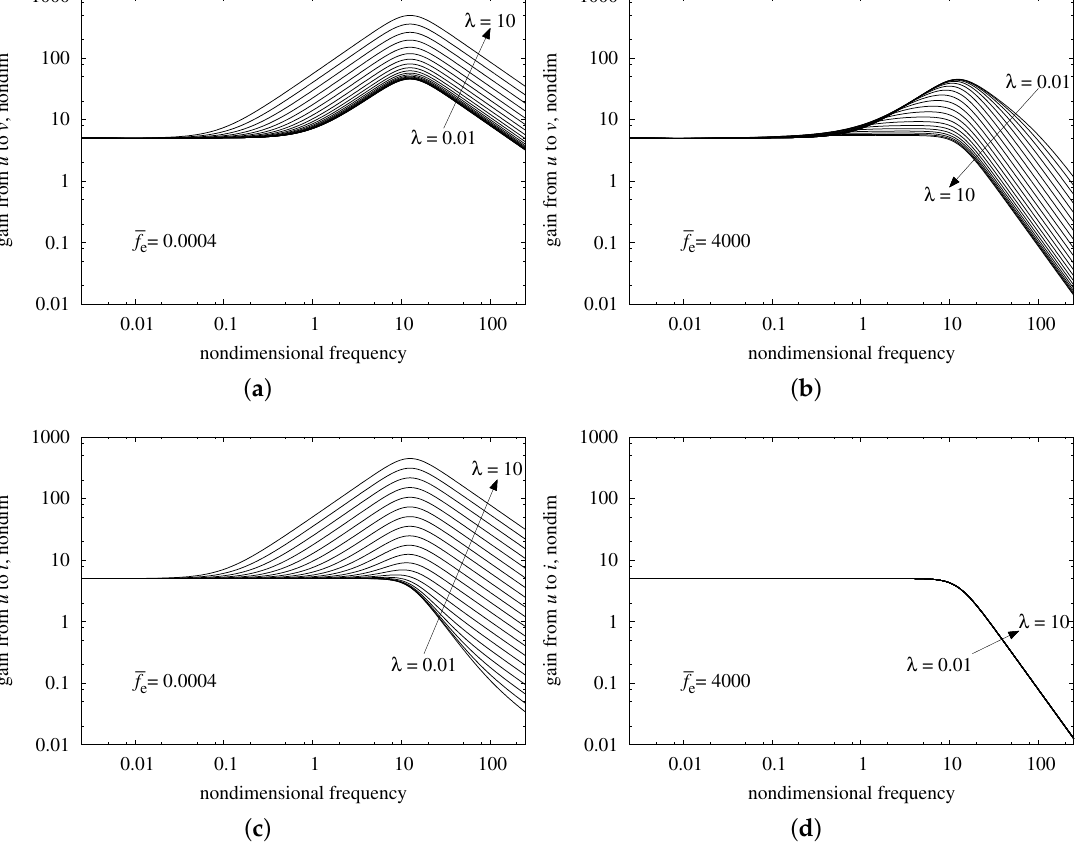
Figure 5. Frequency response of transpermeance and transconductance amplifiers under eddy current effects variation. ( a ) Gain from command voltage to coil voltage: transpermeance ( ¯ f e = 0.0004); ( b ) gain from command voltage to coil voltage: transconductance ( ¯ f e = 4000); ( c ) gain from command voltage to coil current: transpermeance ( ¯ f e = 0.0004); ( d ) gain from command voltage to coil current: transconductance ( ¯ f e =